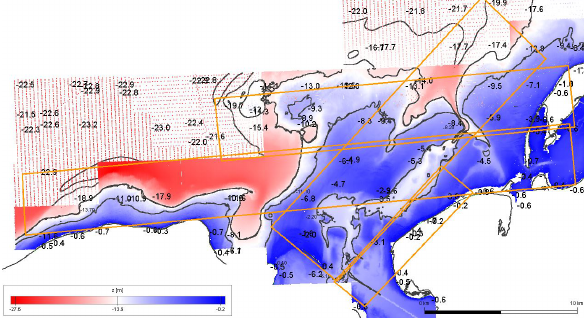
Figure 4: Overview of the water depth in the test areas.